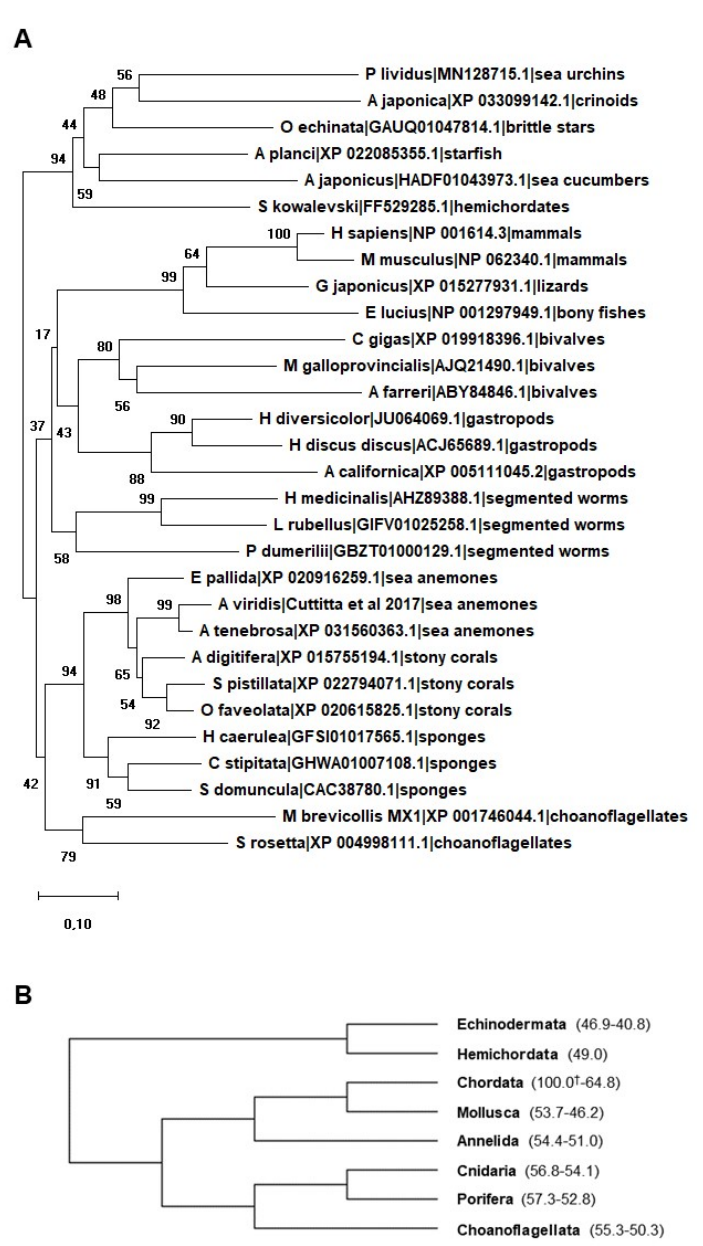
Figure 1. ( A ) Neighbor-joining (NJ) optimal tree based on selected metazoan allograft inflammatory factor-1 (AIF-1)-related proteins. The tree was generated using MEGA X including AIF-1 from different species ranging from mammals to porifera. The amino acid sequences of two choanoflagellates are also included in the tree. All the sequences used were obtained from GenBank at NCBI. The evolutionary history was inferred using the NJ method. The evolutionary distances were computed using the Poisson correction method and are in the units of the number of amino acid substitutions per site. Bootstrap test: 1000 replicates. All ambiguous positions were removed for each sequence pair. ( B ) Condensed tree of ( A ) showing relationships among taxa. Percent identity values (min-max values amongst those observed in each metazoan group) are indicated in parentheses. † indicates Homo sapiens AIF-1 reference identity value (100%).